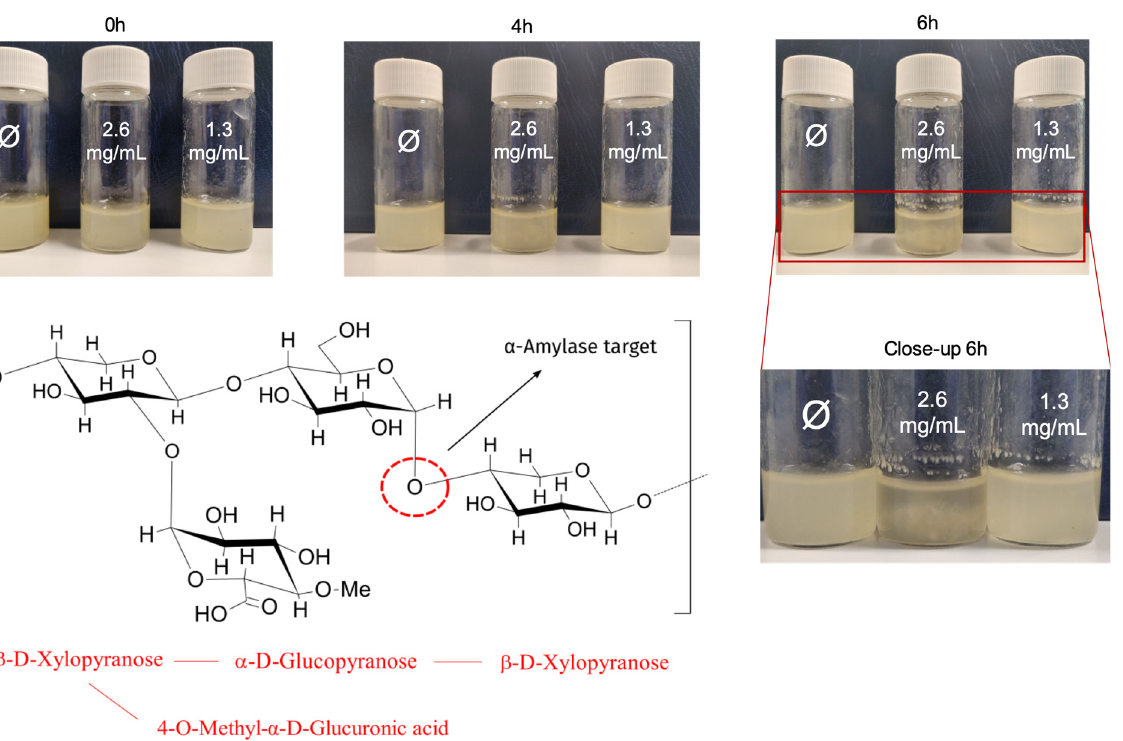
Figure 1. Images of chia suspensions with different α -amylase concentrations over time (0–6 h) with a close-up of the samples at 6 h to better see the differences ( a ), and illustration of the repeating unit of the chia mucilage tetrasaccharide and the putative cleavage site of the α -amylase ( b ). Initially, we decided to qualitatively investigate the polymer degradation triggered by the enzyme within 12 h at pH 7.4 and room temperature. Figure 1a shows images of the chia mucilage (CM) solutions in the presence of different α -amylase concentrations (0–2.6 mg/mL) at different incubation times (0–6 h). This time period was chosen because there were no visible changes after 6 h of incubation. α -Amylase at a concentration of